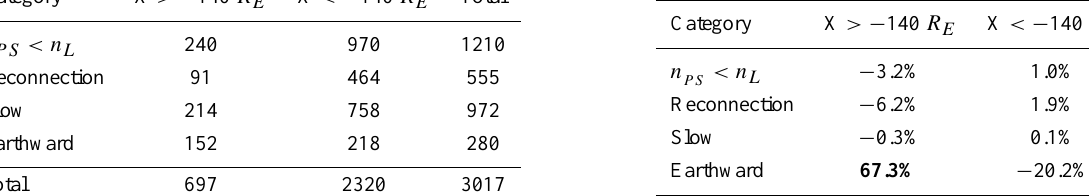
17% of the tailward flows could be driven by the transfer